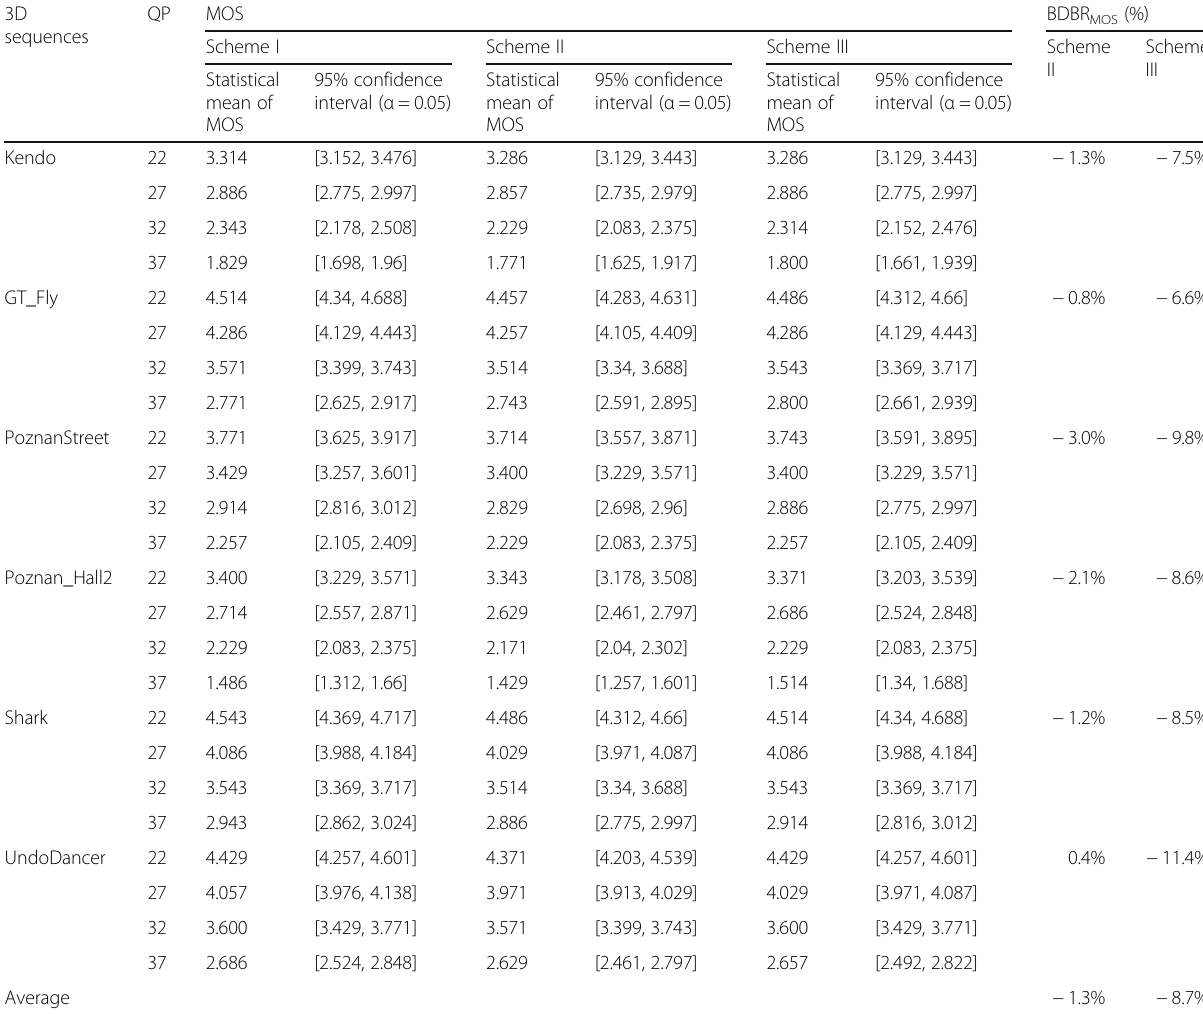
Table 14 The MOS and BDBR MOS for each test video